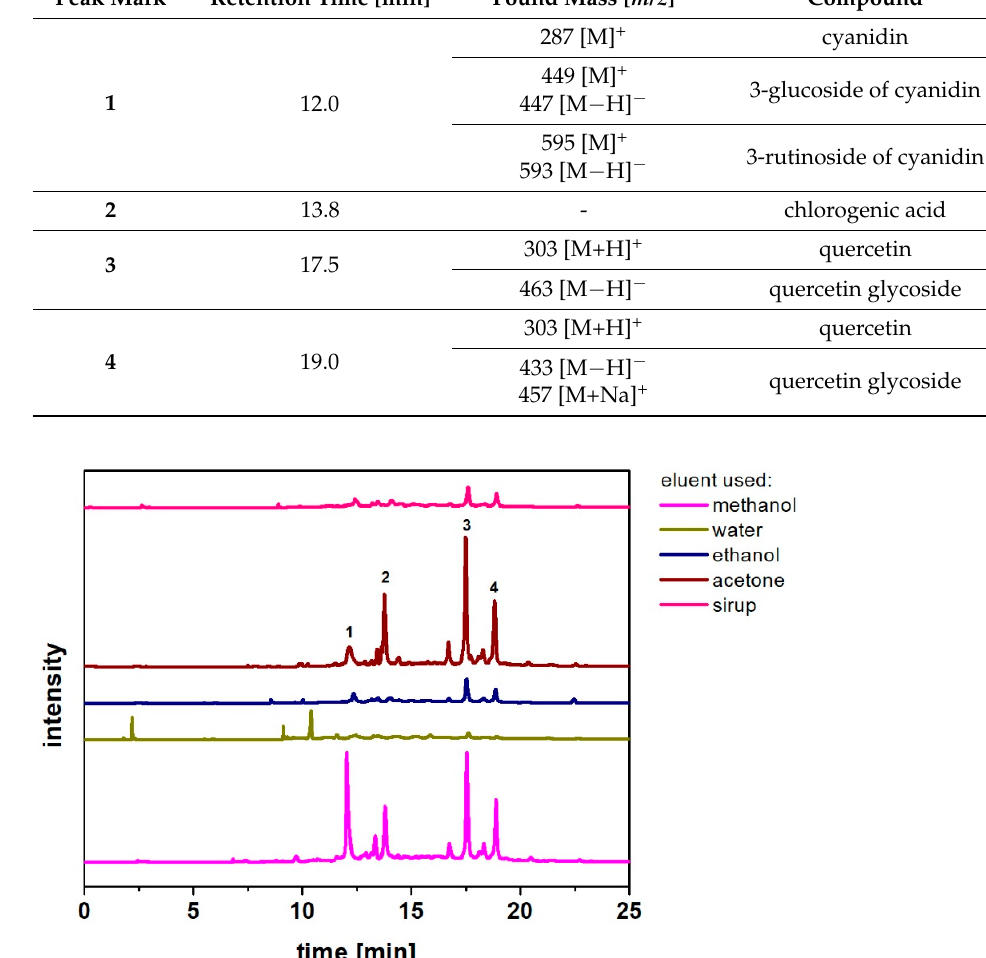
Figure 3. HPLC elution profiles (330 nm) of extracts and sirup. The proposed identification of main components (marks with numbers) was collected in Table 1.